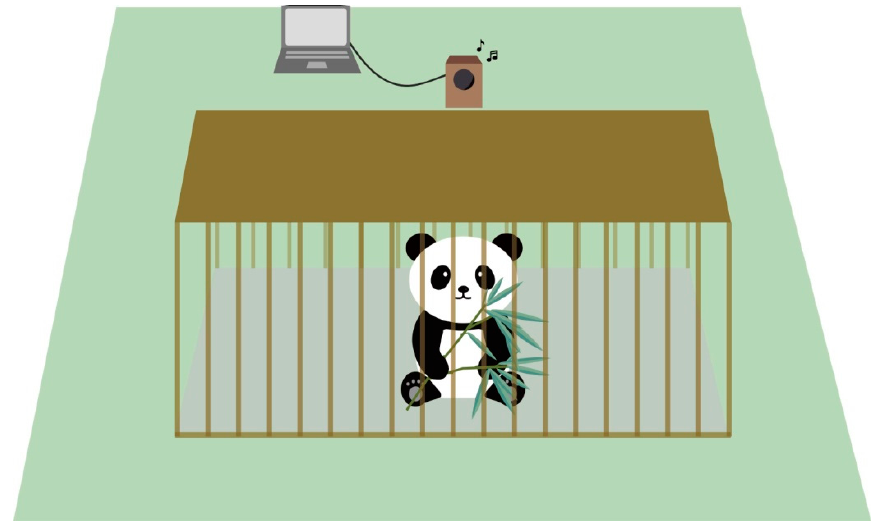
Figure 1. Schematic illustration of the playback setup. Playback experiments were conducted in the home cage of each giant panda where they were free to move. The acoustic equipment and the digital video were placed behind the subjects during recording. As soon as the head of the subject was in line with the speaker, a selected acoustic stimulus was played. The response was recorded when the subjects turned their ears or head towards the speaker.